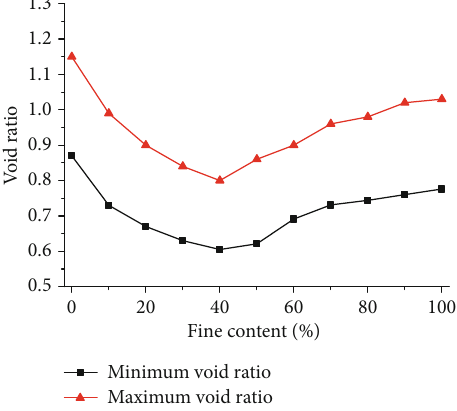
and e fi ne content. max min with